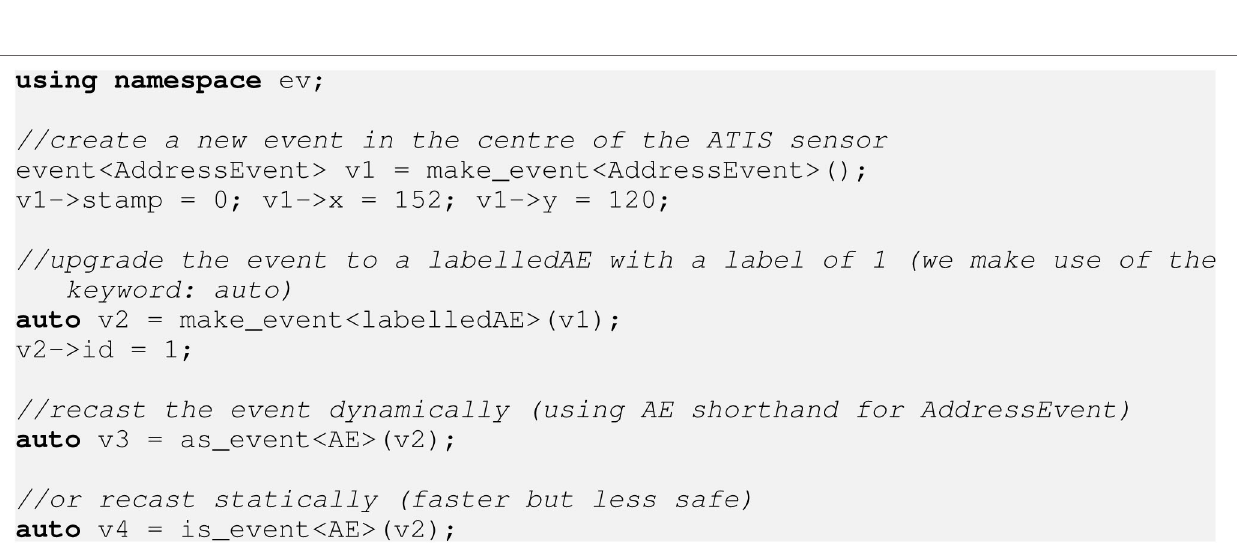
LISTING 1 | Instantiating events using shared pointer wrappers and dynamic casting. The outcome of the code-snippet will be the allocation of v1 as an